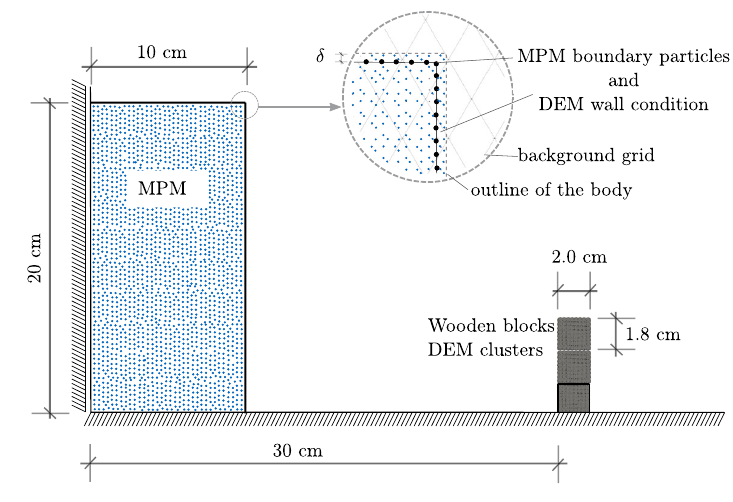
Fig. 9 Granular material calculated with MPM impacting wooden blocks modelled with DEM cluster